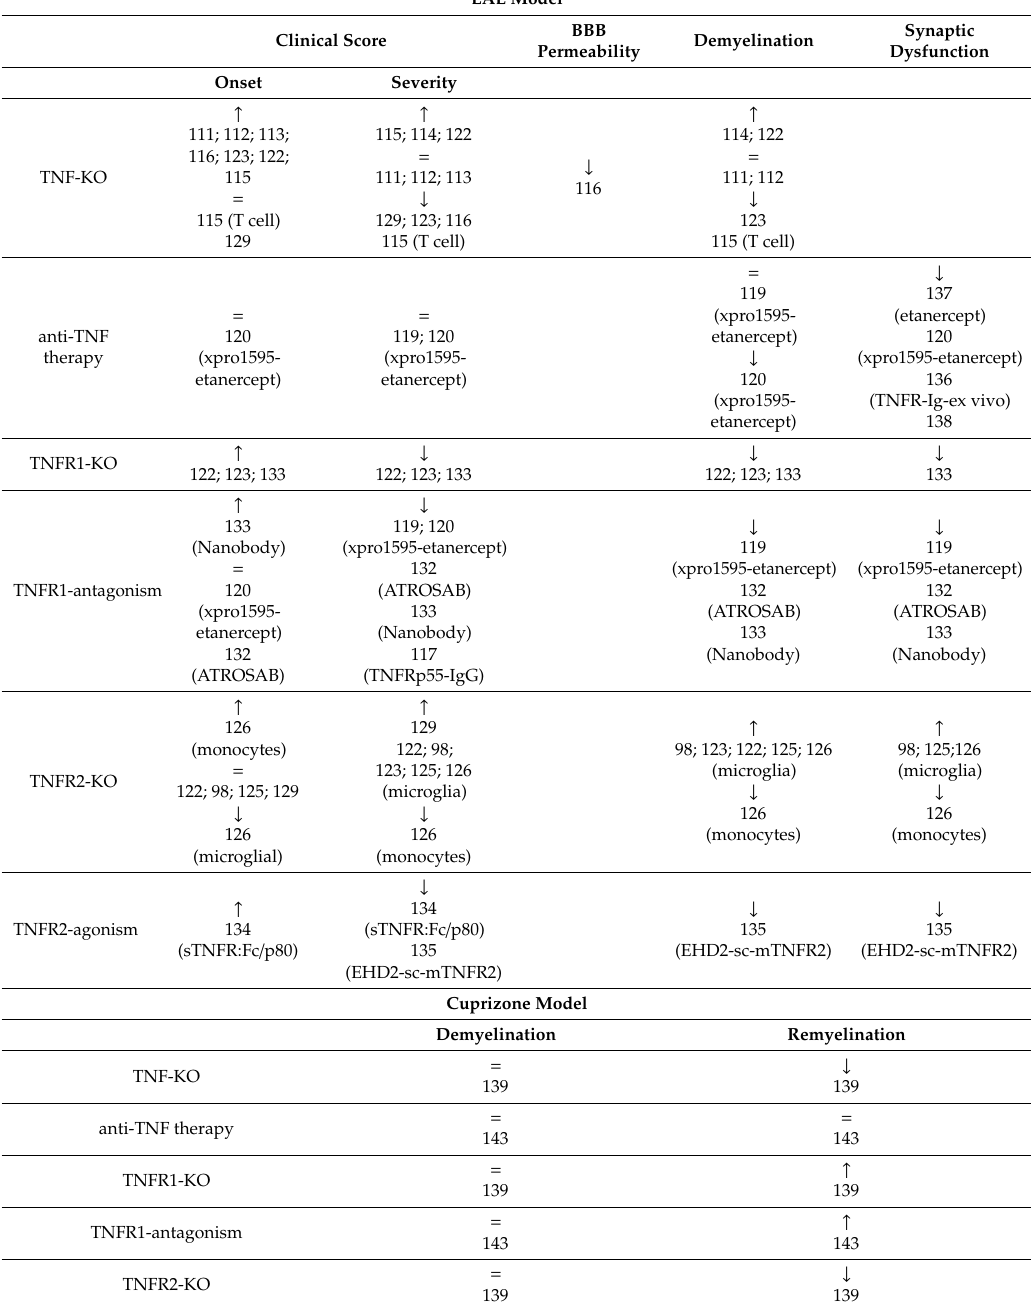
Table 1. Genetic and pharmacological modulation of tumor necrosis (TNF) signaling in animal models of multiple sclerosis